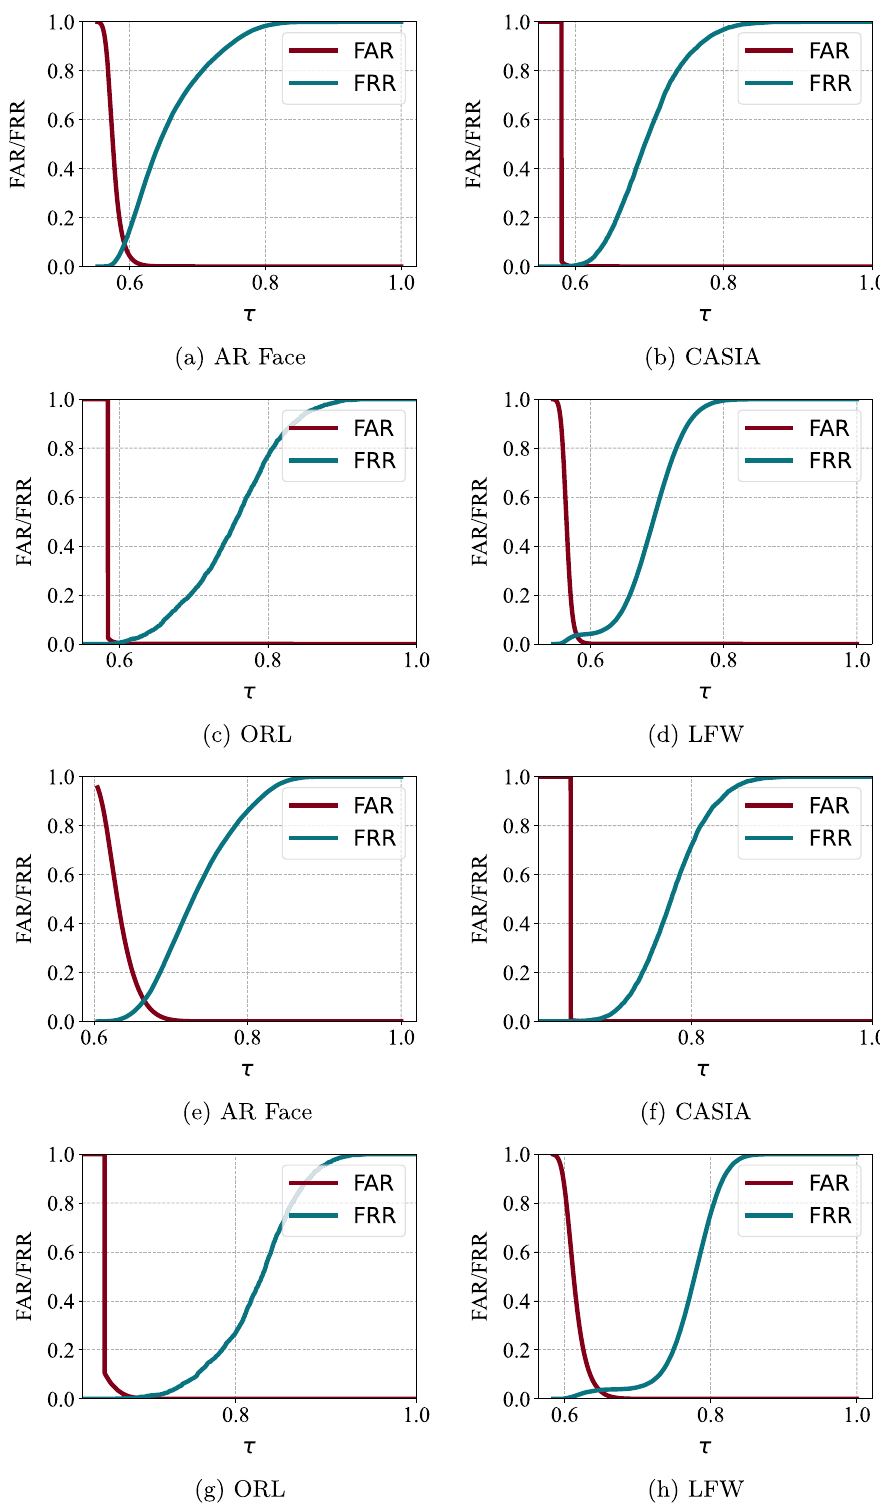
Fig. 8 FAR and FRR change with threshold τ for Euclidean LSH under k = 5000 , N = 2 , c = 1.0 and Cosine LSH under k = 10,000 , N = 2 , d = 2 . a – d show the result of Euclidean LSH-based scheme, while e – h show the result of Cosine LSH-based